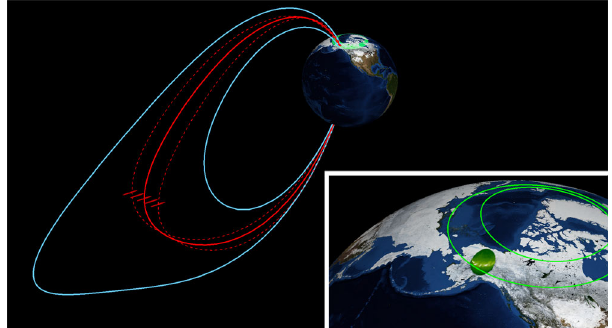
Fig. 4 To-scale estimate of the spatial characteristics of the substorm instability. Auroral observations are mapped to the equatorial magnetotail using a T96 magnetic fi eld model 27 . The auroral beads map to the transition region between dipolar and stretched magnetic fi eld topology. Inset: Auroral bead measurements used to estimate the spatial scales of the substorm onset region in space, with the inner and outer bounds of a Feldstein auroral oval for reference